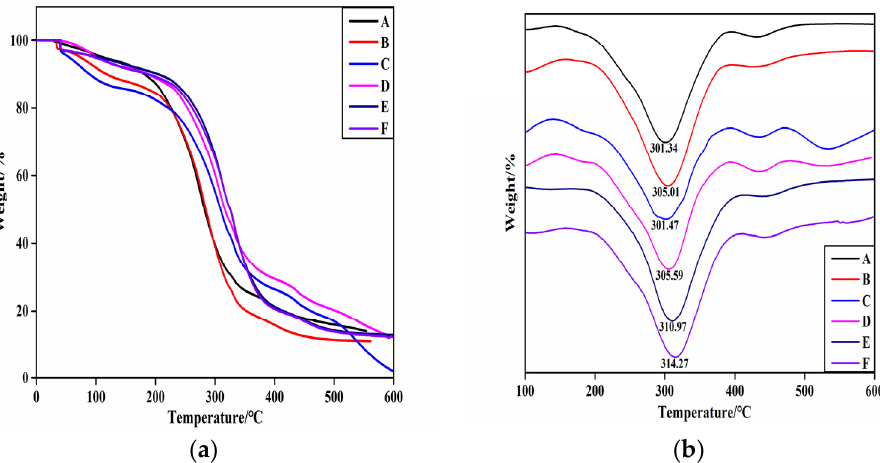
Figure 7. The ( a ) TG; ( b ) DTG curves of composite membrane samples (A) starch–PVA; (B)